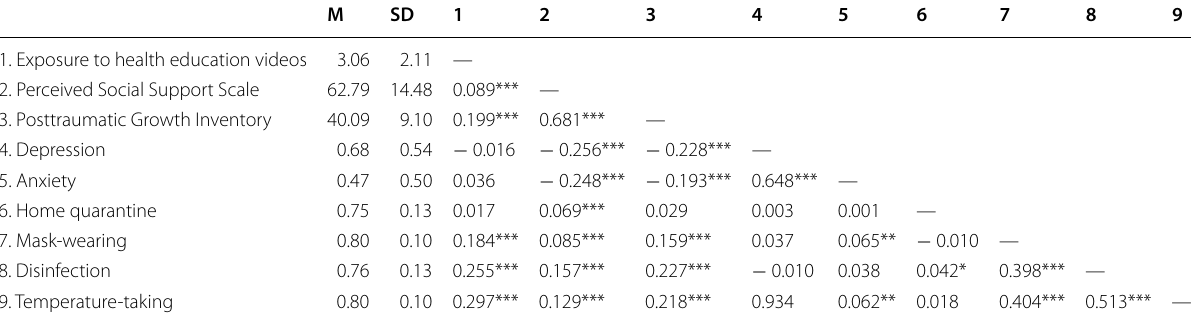
Table 2 Means, Standard Deviations, correlations among exposure to health education videos, PSSS, PTGI, mental health problems and health-related behaviors (N 2685) =